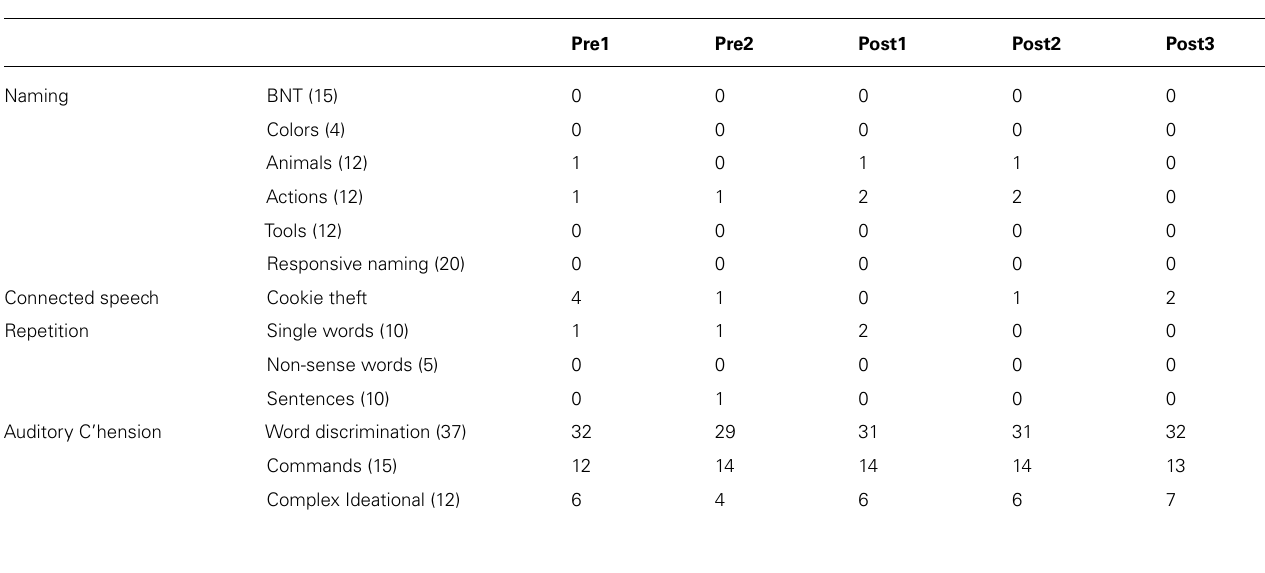
Table 3 | BDAE scores for participant